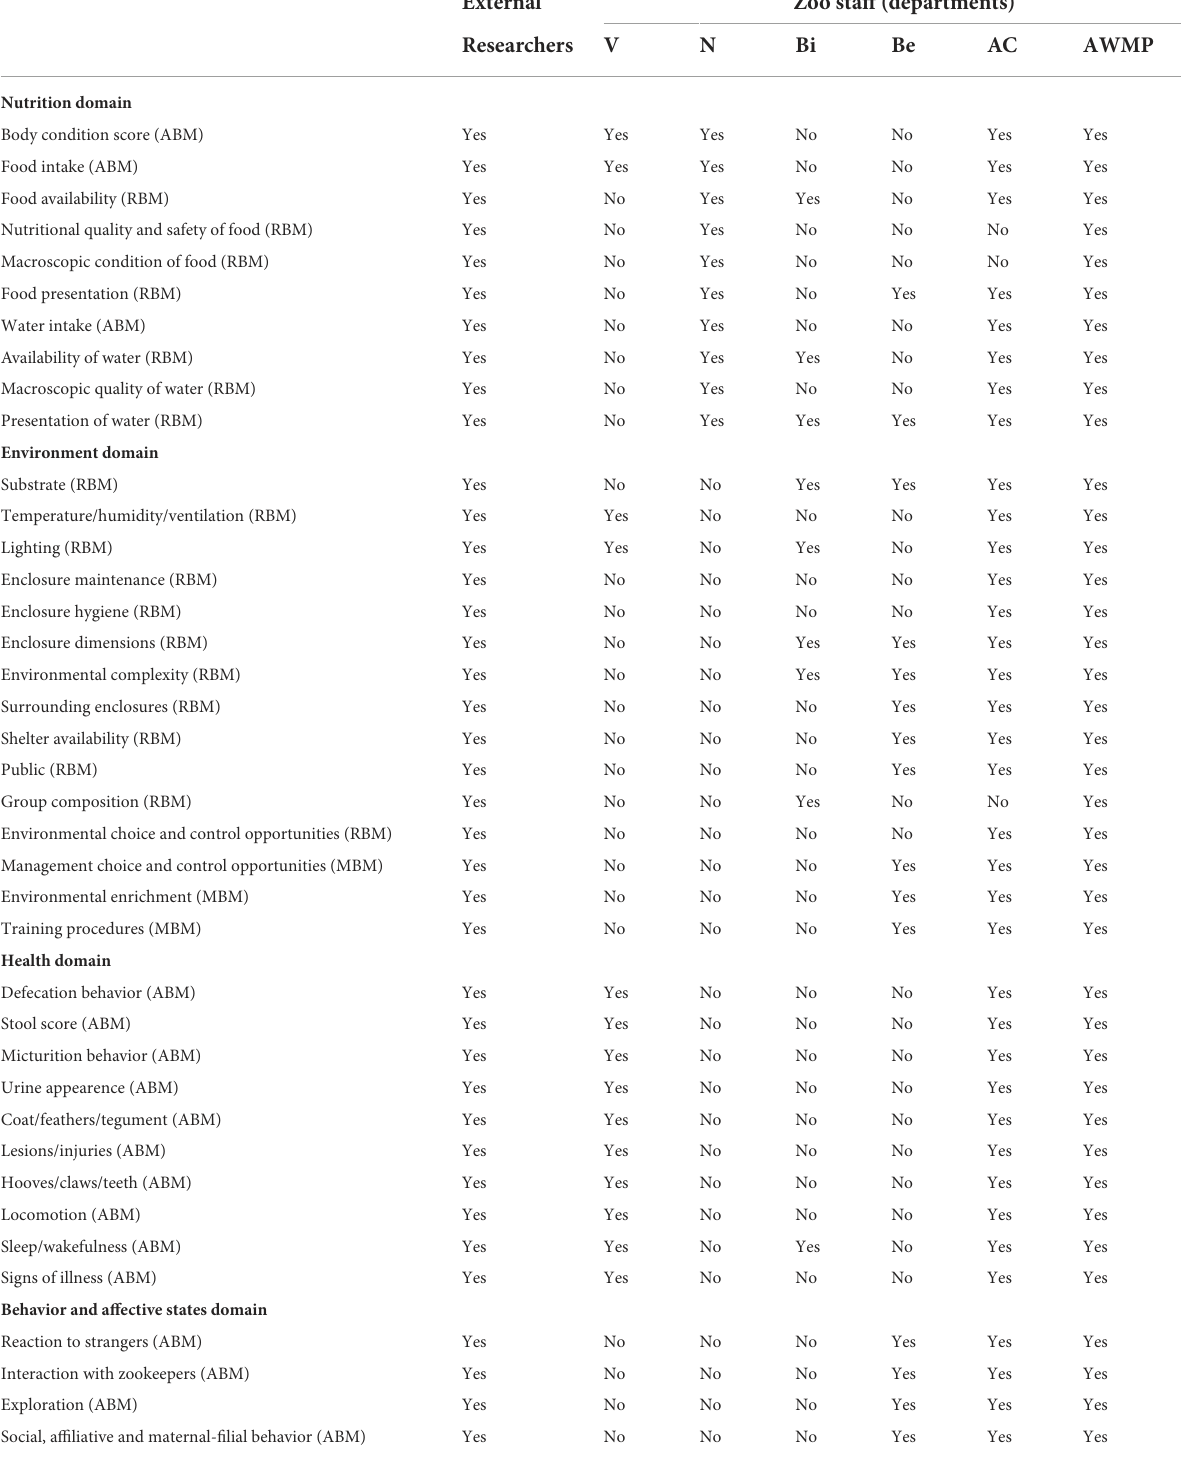
TABLE 1 List of indicators selected to test on-field reliability and feasibility, and sentinels assigned according to their availability, area of daily performance and experience. Sentinels assigned to the on-field feasibility and reliability test of each indicator External Zoo staff